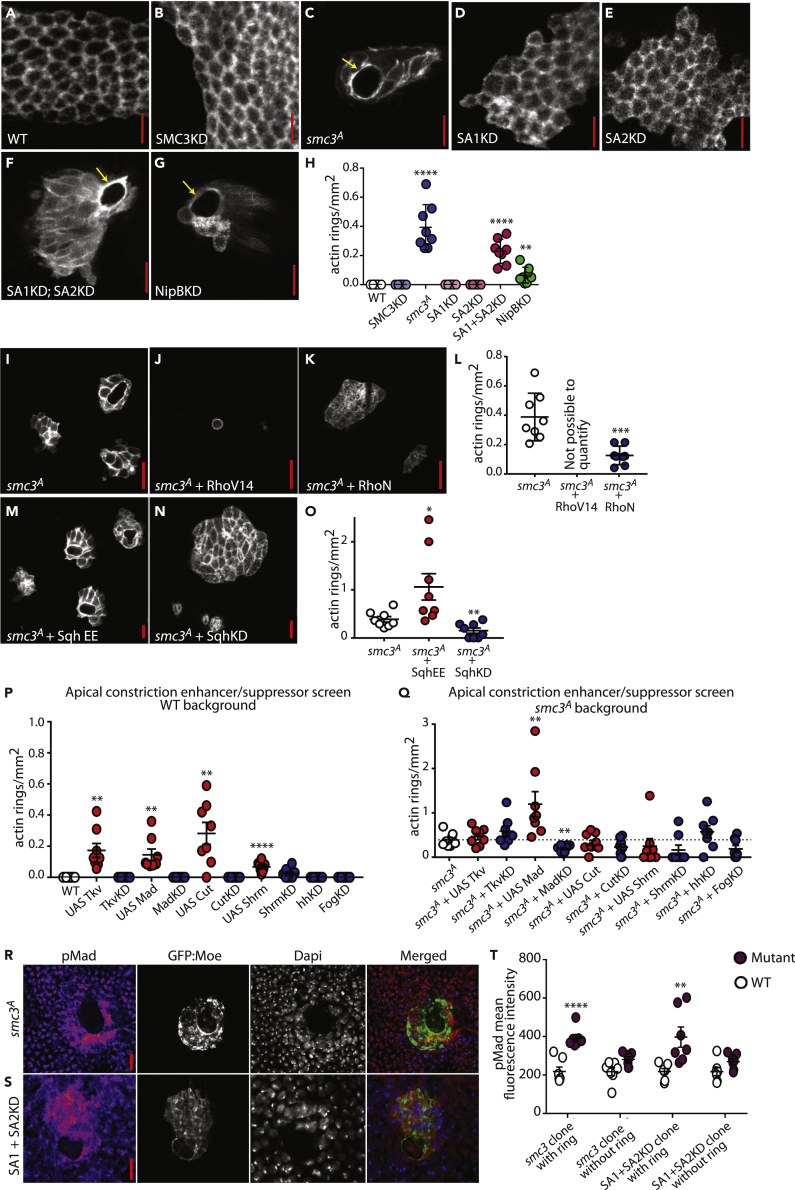
A More Severe Cohesin LOF Induces Actin Ring Formation(A–G) GFP:moe positively marked WT (A), SMC3KD (B), smc3A(C), SA1KD (D), SA2KD (E), SA1KD; SA2KD (F), and NipBKD (G) clones. Actin rich rings (yellow arrows) were observed in smc3A, SA1, and SA2 simultaneous KD and NipBKD clones.(H) Quantification of the number of actin rings per square millimeter of clonal tissue. Eight animals were analyzed for each genotype.(I–O) GFP:moe positively marked clones ((I) smc3A; (J) smc3A + RhoV14; (K) smc3A + RhoN; (M) smc3A + Sqh EE; (N) smc3A + SqhKD). Dominant-negative Rho (RhoN) and SqhKD inhibit actin ring formation in smc3A clones; phosphomimetic Sqh (SqhEE) increases the number of clones with actin rings. Quantified in (L) and (O) showing the number of actin rings or delaminated clones per square millimeter of clonal tissue. Each dot represents one animal. smc3A + RhoV14 resulted in very small unicellular clones (J) or no clones at all and could not be quantified.(P and Q) Genes involved in apical constriction were either knocked down or overexpressed in GFP:moe positively marked clones, either on their own (P) or within smc3A clones (Q). Quantification shows the number of actin rings or delaminated clones per square millimeter of clonal tissue. Each dot represents 1 animal.(R and S) GFP:moe-labeled smc3A (R) and SA1 + SA2KD (S) clones stained for the active form of the Dpp signaling effector, phosphorylated Mad (pMad).(T) Quantification of mean fluorescence intensity from the nuclei of cells within clones, with and without actin rings, compared with WT tissue within the same animal. 35 nuclei from 7 animals were measured. Each dot represents one animal. Scale bars, 10 μm. Error bars = ± SEM. Statistical analysis: Student's t test. p > 0.05 was considered not significant, ∗p < 0.05, ∗∗p < 0.01, ∗∗∗p < 0.001, ∗∗∗∗p < 0.0001.See also Figure S7.